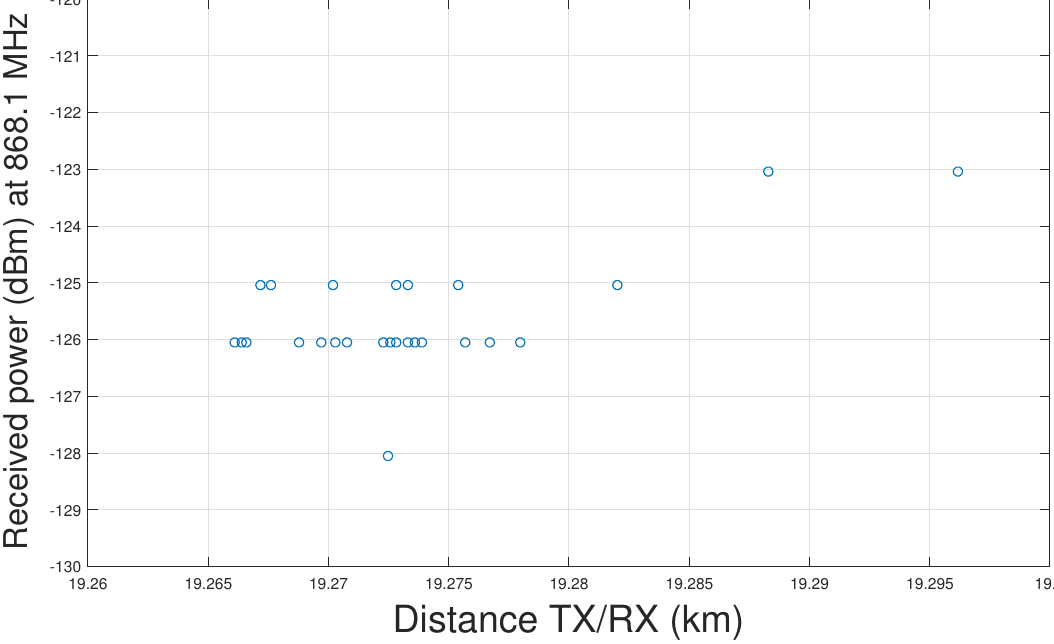
Figure 14. Packets received in NLoS conditions, probably via